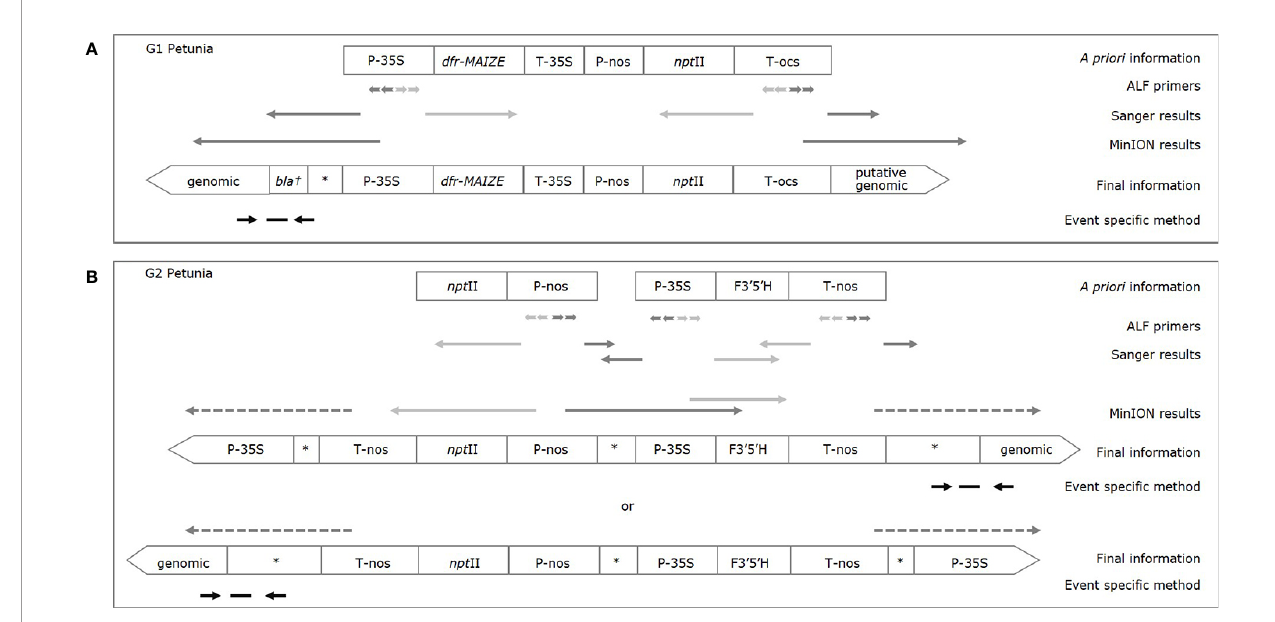
FIGURE 2 | Characterization of G1 (A) and G2 (B) petunias. A priori information is based on (real-time) PCR results and available literature, fi nal information is based on Sanger and MinION sequencing. Light grey arrows indicate enrichment into known sequence; dark grey arrows enrichment into unknown sequence, dashed arrows indicate a putative orientation. Event speci fi c primers and probe are indicated by black arrows and a horizontal dash, respectively; an asterisk indicates a generic GM sequence (e.g. plasmid, vector); the dagger represents a putative partial